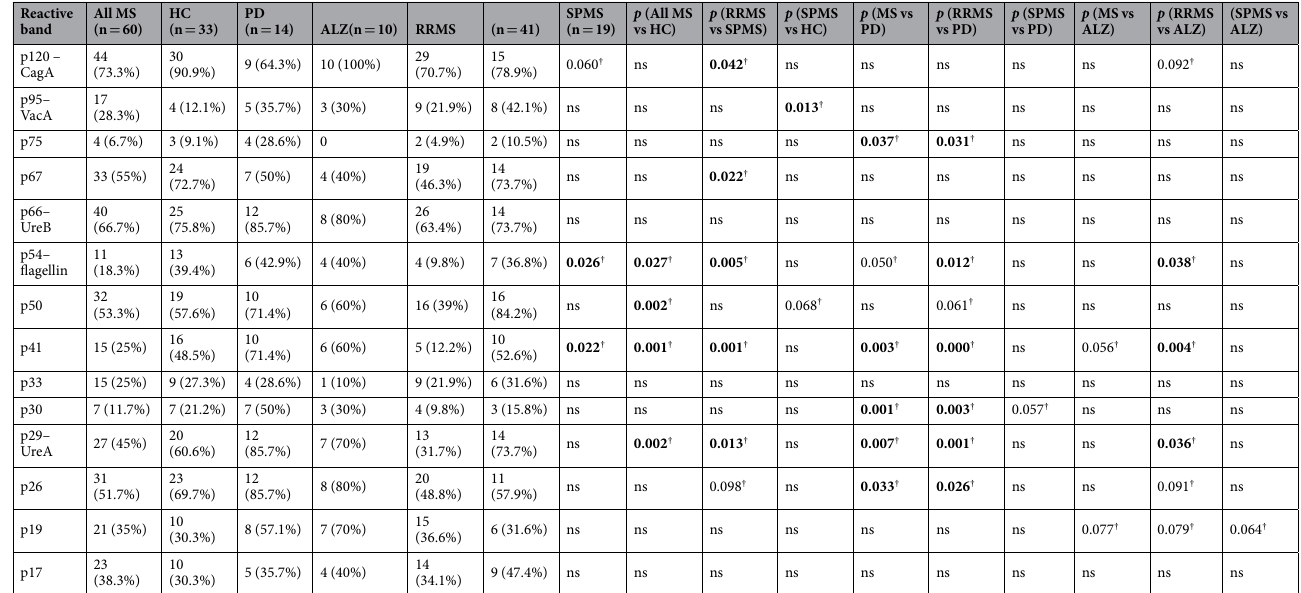
Table 2. Frequencies of immunoreactive Hp-specific antigens as detected by Western immunoblotting in sera of 60 anti-Hp( + ) patients with multiple sclerosis (MS), including 41 relapsing-remitting (RRMS) patients and 19 secondary progressive (SPMS) patients, 33 anti-Hp( + ) healthy controls (HC), 14 anti-Hp( + ) patients with Parkinson’s disease (PD) and 10 anti-Hp( + ) patients with Alzheimer’s disease (ALZ). Data represent mean ± standard deviation. † p -values were calculated using Pearson Chi-Square or Fisher’s Exact Test (2-sided). p -values < 0.05 are shown in bold; p -values with a statistical tendency ( < 0.1) are also shown. Abbreviations: CagA, protein from cytotoxin-associated gene A; FSH, flagellar sheath protein; ns, not significant; UreA, urease A; UreB, urease B; VacA, vacuolating cytotoxin